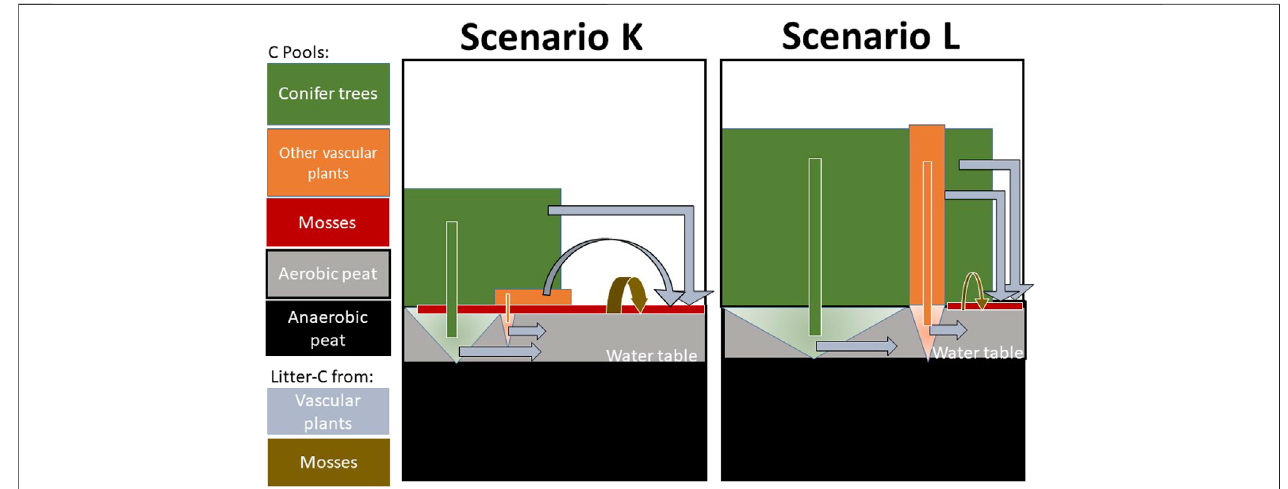
FIGURE 1 | Overview of the two simulated systems K and L, where K is nutrient-poor. Vascular plants, Vegetation1 (conifers) dominate at L, both in height and coverage.Vegetation2consistsalsoofvascularplants,mainlyofsmallshrubsbutalsotallbirchtreesatL.Mossesareincorporatedinthesoilsurfaceandcoverthesoilat K but are sparse at L. Note that mosseshave no roots and add litter only to the soil layer just below themosses. The soil column is divided into 10layersto 2.5 mdepth, eachwiththreesoilorganiccarboncomponentswithdifferentdecompositionrates.Thesurfacesoilisoxic,inaveragetoadepthof0.3 m,wheremostrootscanbe